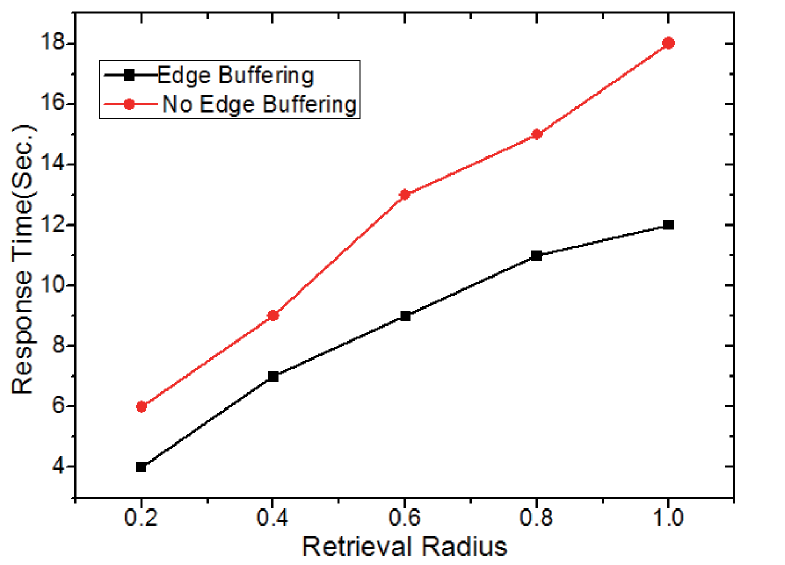
Fig 14. Effect of edge buffering